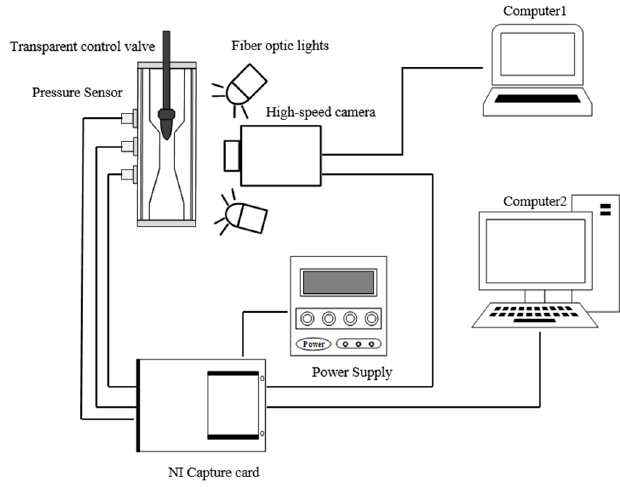
Figure 2. Schematic of the synchronous measurement system.